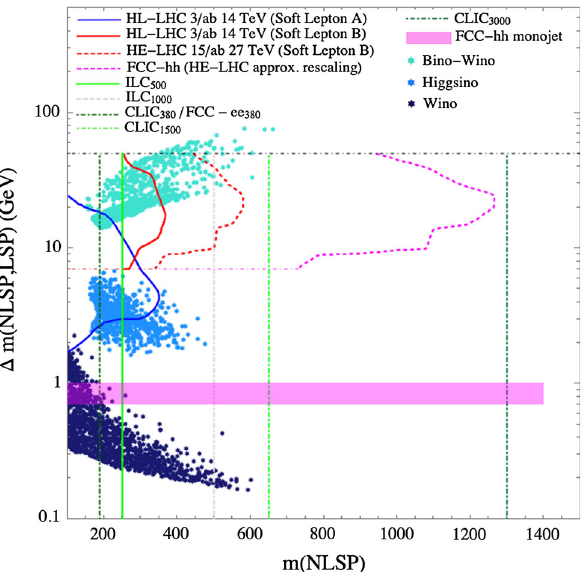
Fig. 22 m ˜ χ ± – (cid:6) m planewithanticipatedlimitsfromcompressedspec- 1 tra searches at the HL-LHC, the HE-LHC, FCC-hh and ILC500, ILC1000, CLIC380, CLIC1500, CLIC3000 (see text), original taken from Ref. [135]. Not included are disappearing track searches. Shown in blue, dark blue, turquoise are the points surviving all current con- straints in the case of higgsino DM, wino DM and bino/wino DM with ˜ χ ± -coannihilation, 1